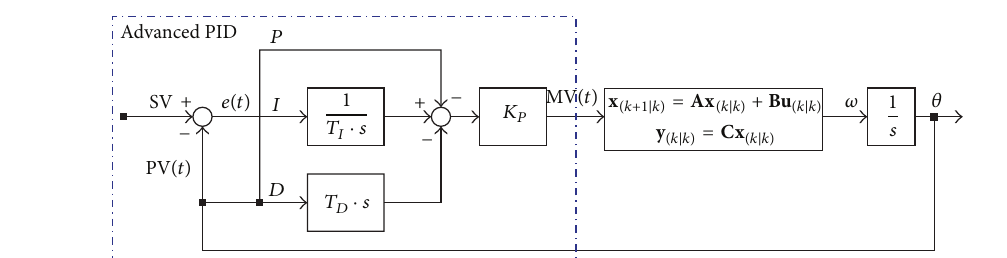
Figure 8: Step response of the azimuth motor speed.